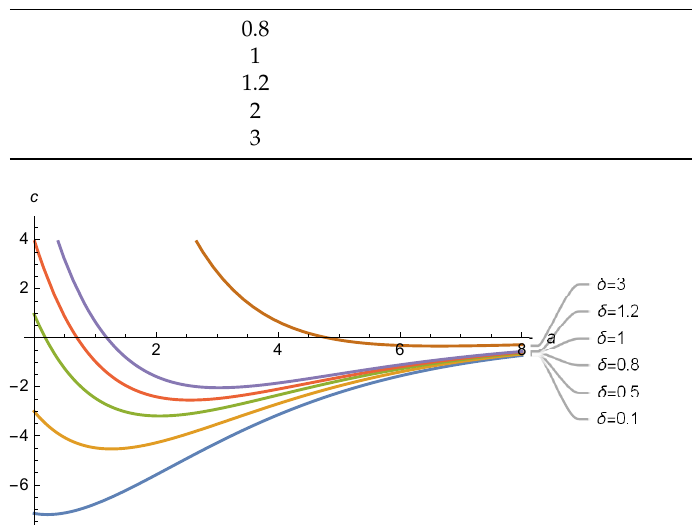
Figure 6. c ( a ) for δ = 0.1,0.5,0.8,1,1.2,3.